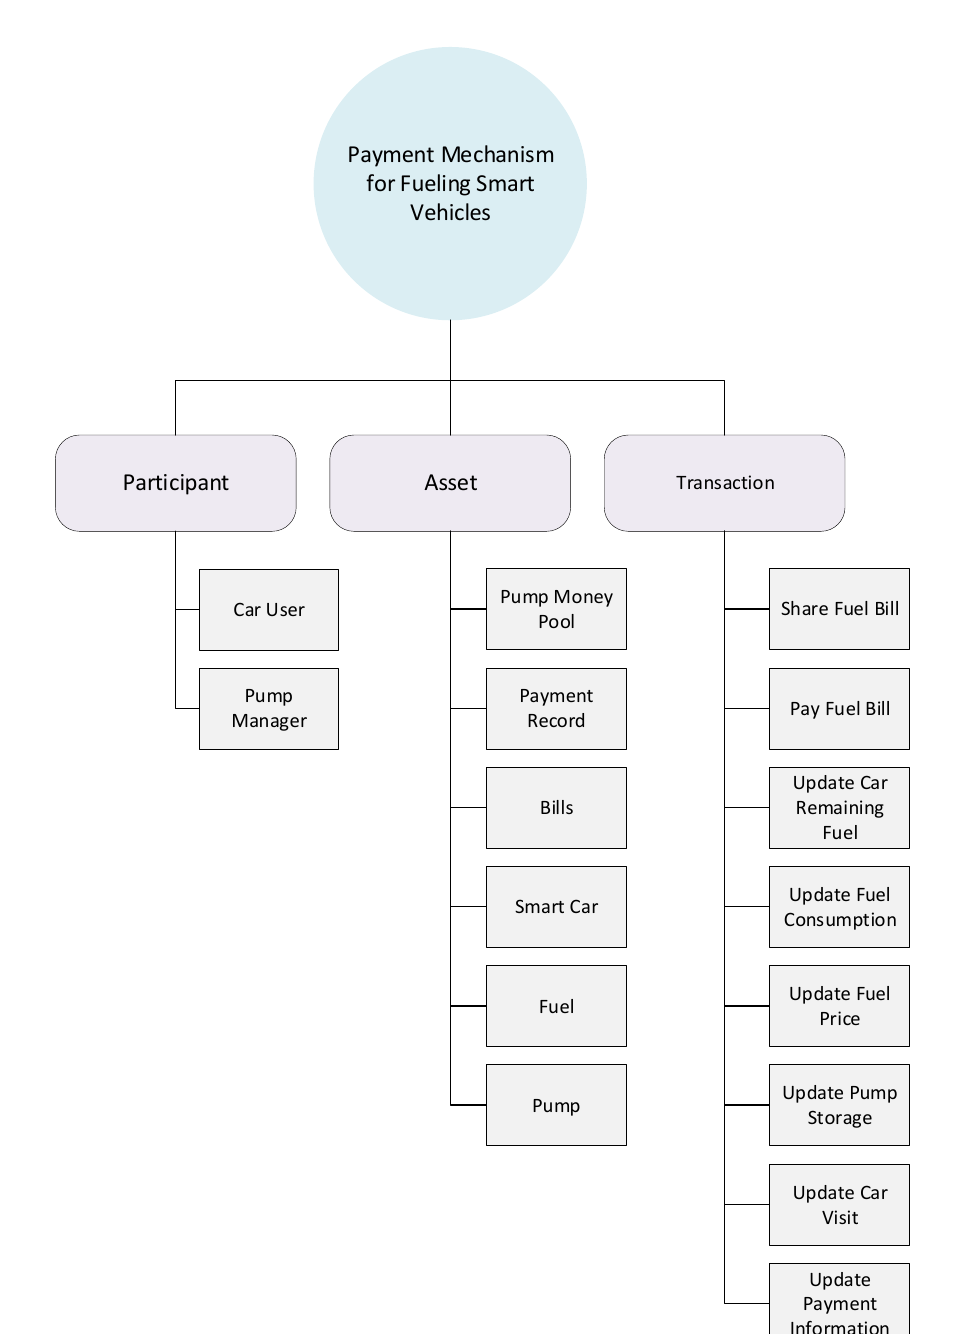
Figure 9. Business model of the proposed blockchain